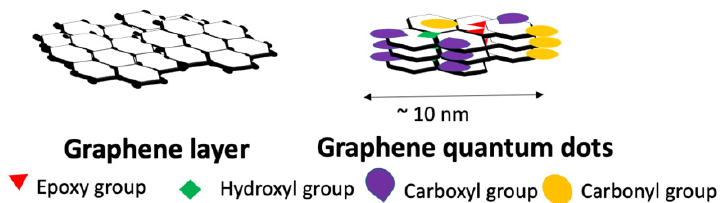
Figure 4. Structure of graphene and graphene quantum dots.